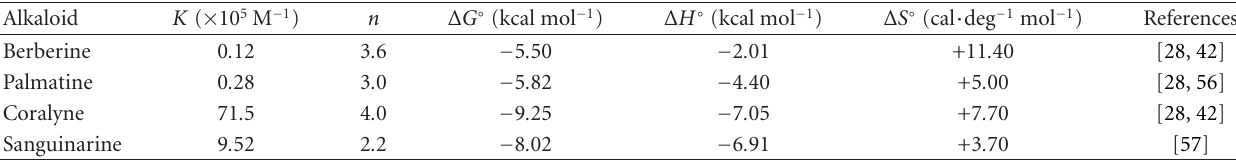
Table 3: Thermodynamic parameters for the interaction of various alkaloids with calf thymus DNA complexation obtained from isothermal titration calorimetric studies a .